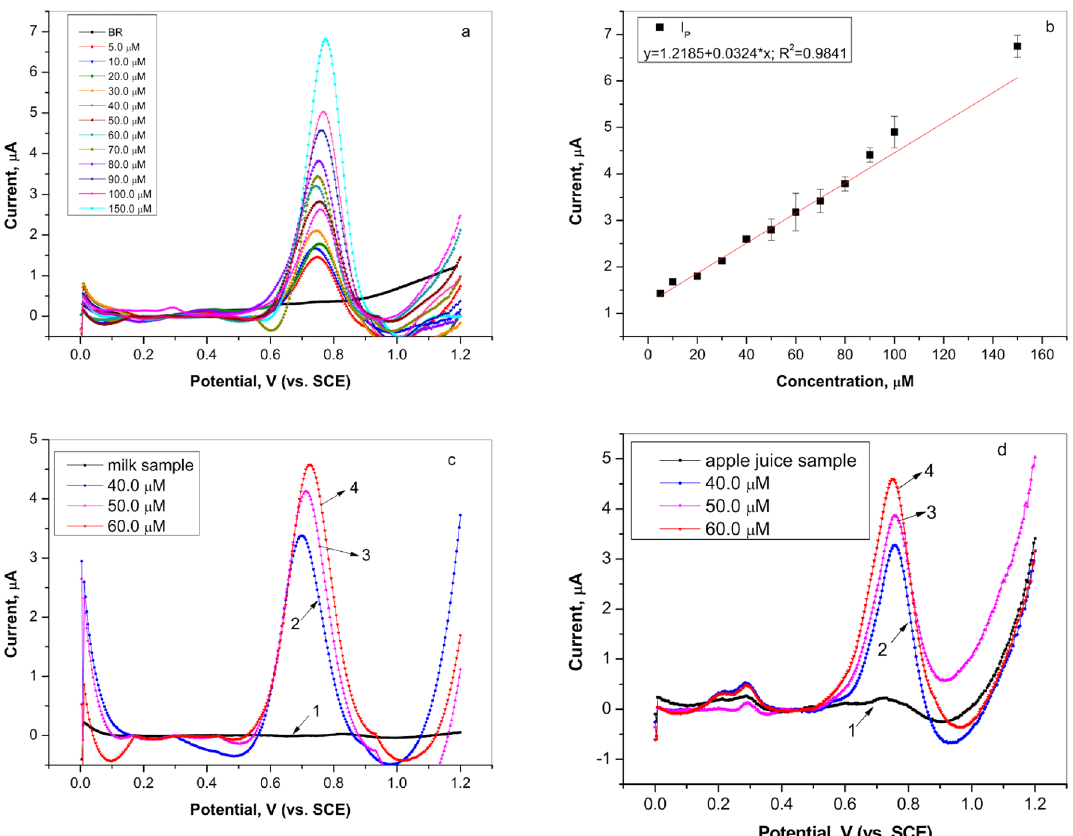
Figure 5. ( a ) Differential pulse voltammogram of L-tryptophan in the concentration range from 5.0 to 150.0 µM on graphite electrode in Britton–Robinson buffer solution (pH 4.0), scan rate 50.0 mV/s (curves subjected to baseline correction); ( b ) The dependence of peak current on L-tryptophan concentration (investigated concentration range 5.0 µM–150.0 µM); ( c ) Differential pulse voltammogram of spiked L-tryptophan in milk sample on graphite electrode: (1) milk sample in Britton–Robinson buffer solution; (2) milk sample with added 40.0 µM of L-tryptophan; (3) milk sample with added 50.0 µM of L-tryptophan, and (4) milk sample with added 60.0 µM of L-tryptophan, scan rate 50 mV/s (curves subjected to baseline correction); ( d ) Differential pulse voltammogram of spiked L-tryptophan in apple juice sample on graphite electrode: (1) apple juice sample in Britton–Robinson buffer solution; (2) apple juice sample with added 40.0 µM of L-tryptophan; (3) apple juice sample with added 50.0 µM of L-tryptophan, and (4) apple juice sample with